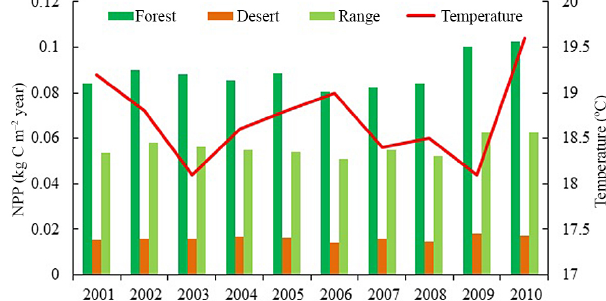
Figure 8. Average NPP changes of each type of land use regarding the annual average temperature